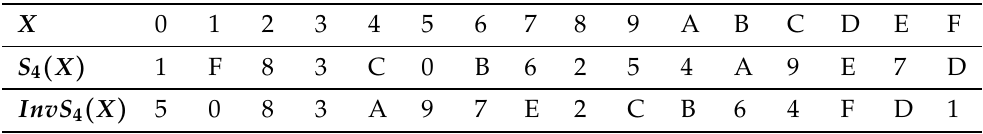
Table 5. Firth S-Box of Serpent defined as S 4 ( X ) .